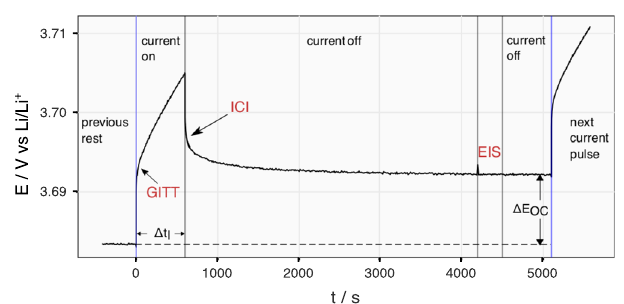
Fig.2|Modi fi edGITTprotocoldesignedtocomparetheresultsfromtheGITT,